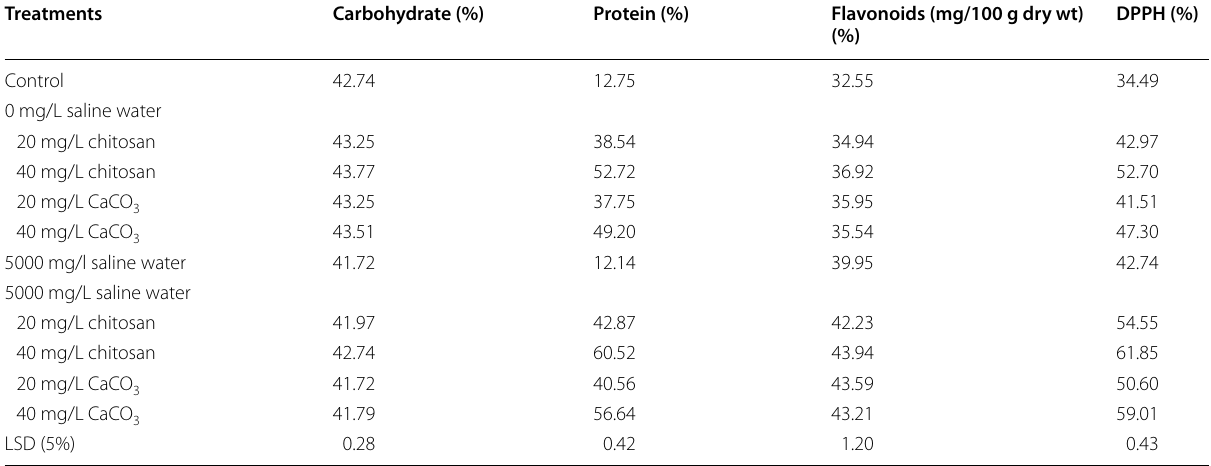
Table 7 Effect of chitosan and calcium carbonate (0, 20 and 40 mg/L) on carbohydrates%, protein%, flavonoids (mg/100 g